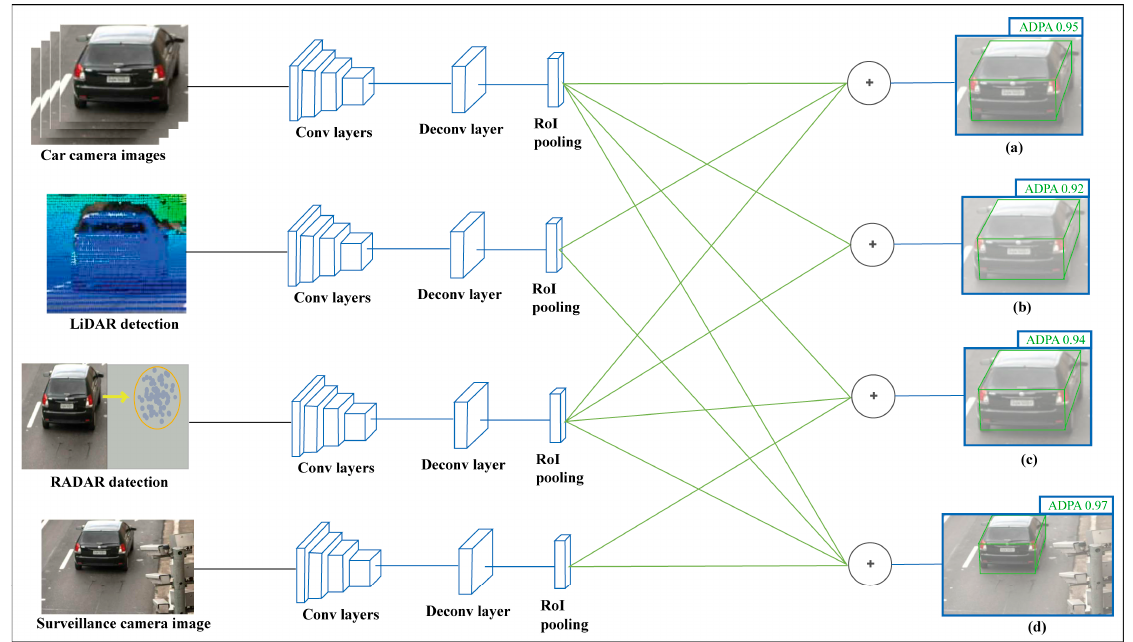
Figure 14. Comparative ADPA distributed fusion of different sensors. ( a ) Car camera, LiDAR, and RADAR detection, ( b ) car camera and advanced RADAR detection, ( c ) car camera, RADAR, and surveillance camera detection, and ( d ) FSCDS detection. Table 4. Compressional performance analysis of traditional fusion and the proposed FSCDS.